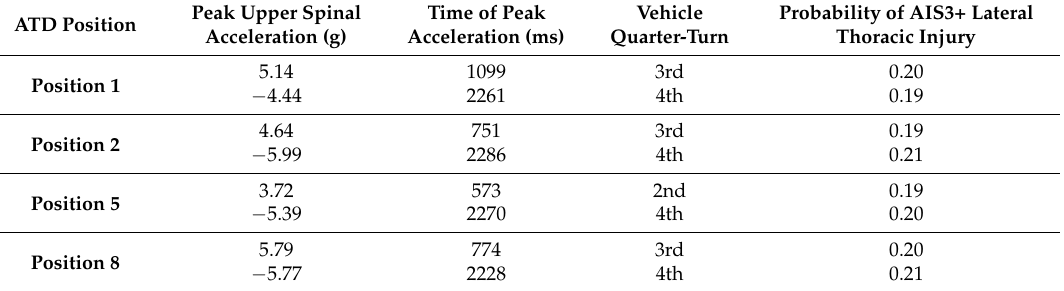
Table 7. Upper spinal acceleration results.